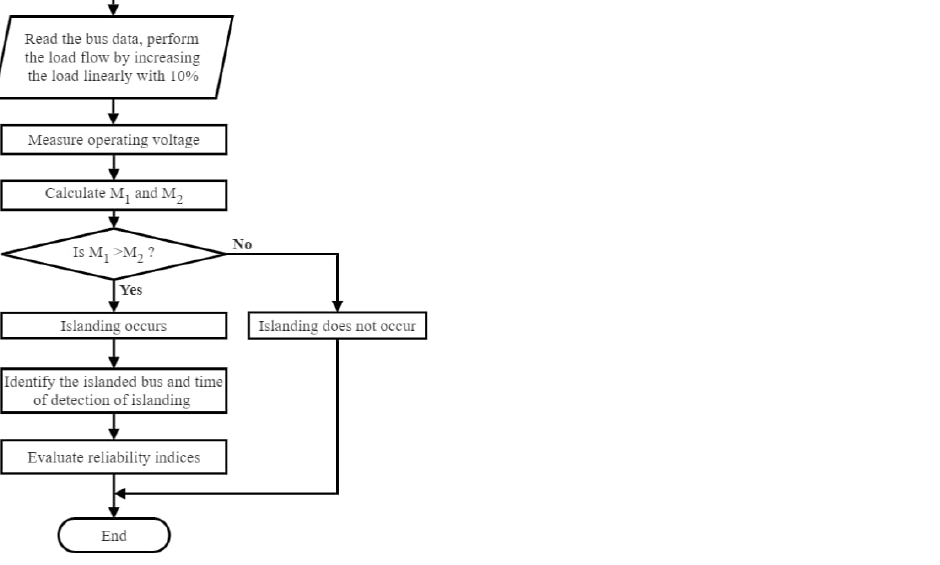
Figure 1. Flowchart using v&f index variation method for islanding detection with reconfiguration